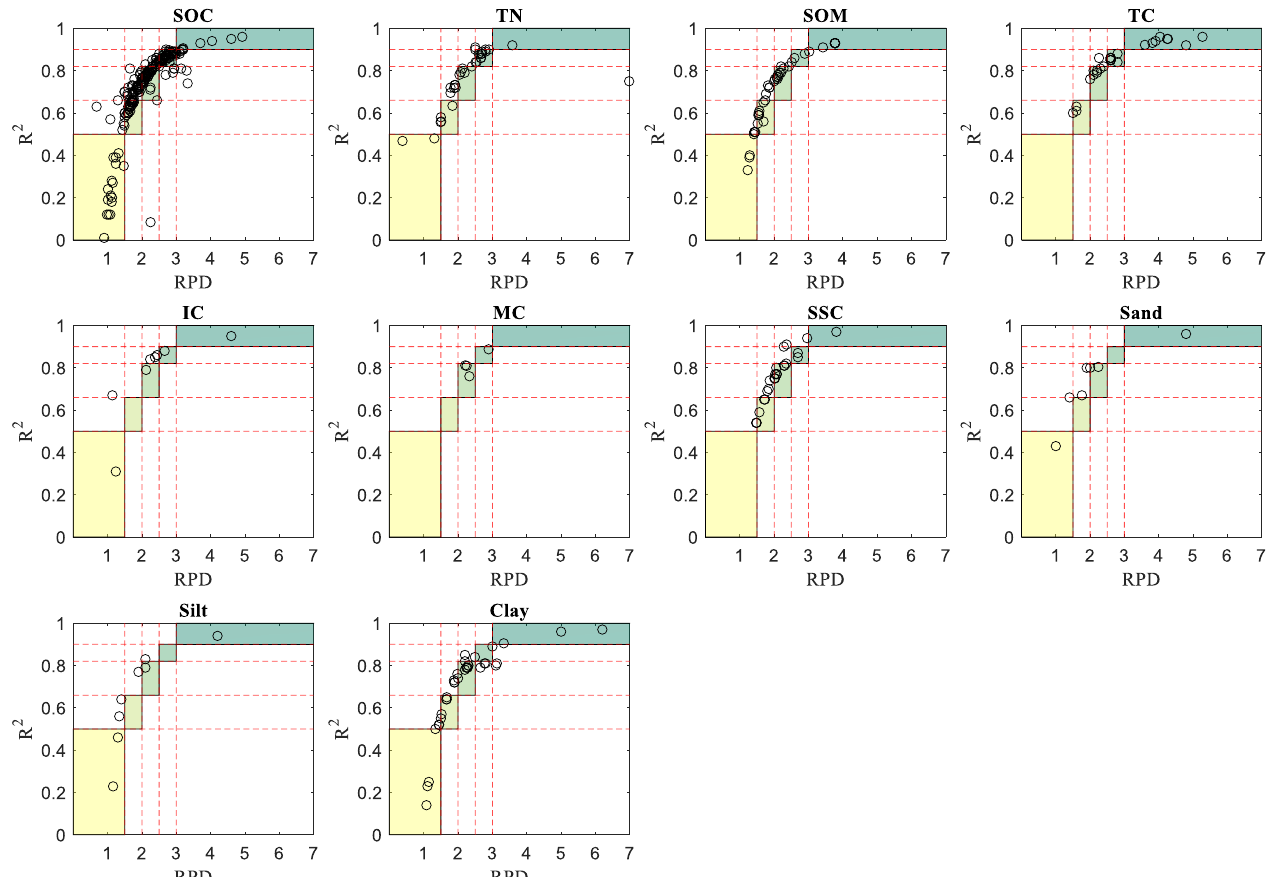
Figure 9. The goodness of prediction evaluation. Colors from green to yellow represent excellent, good, approximate quantitative predictions, distinguishable between high and low values, and unsuccessful, respectively.